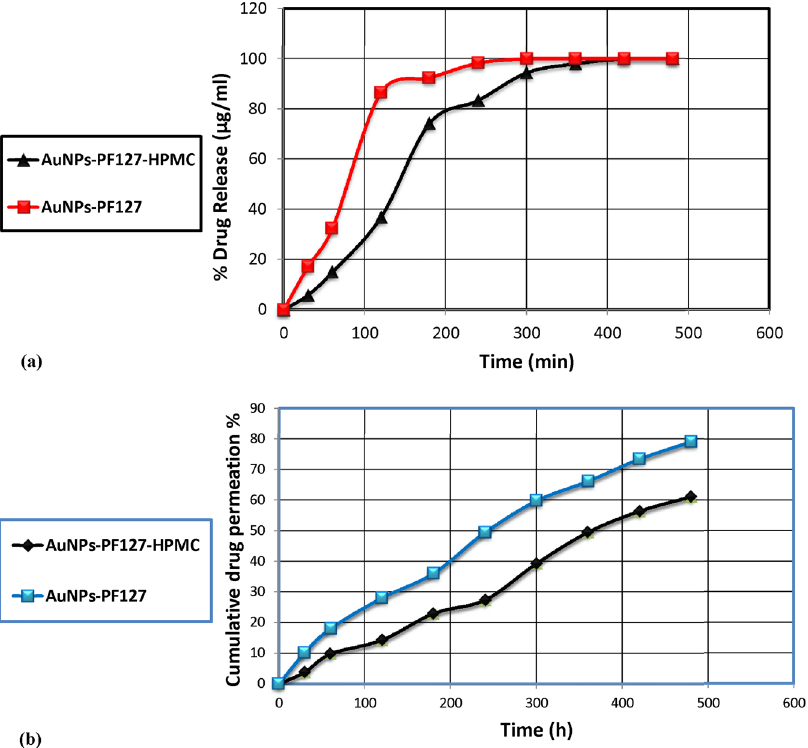
Figure 3. Release of AuNPs from PF127 and PF127-HPMC thermoresponsive gels in phosphate buffer (pH 7.4) at 37 °C. ( a ) and Permeation studies through excised mice skin by F1(AuNPs-PF127) and F2 (AuNPs-PF127- HPMC) thermoresponsive gels ( b ) with the same drug concentration (0.5% w/w).